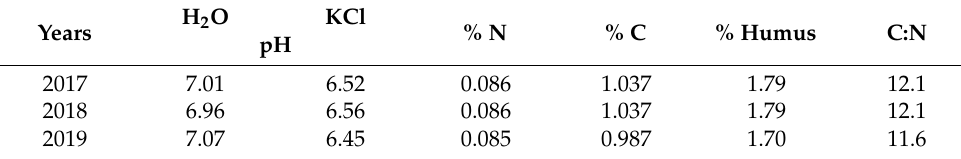
Table 1. Basic chemical properties of the experimental field soil.